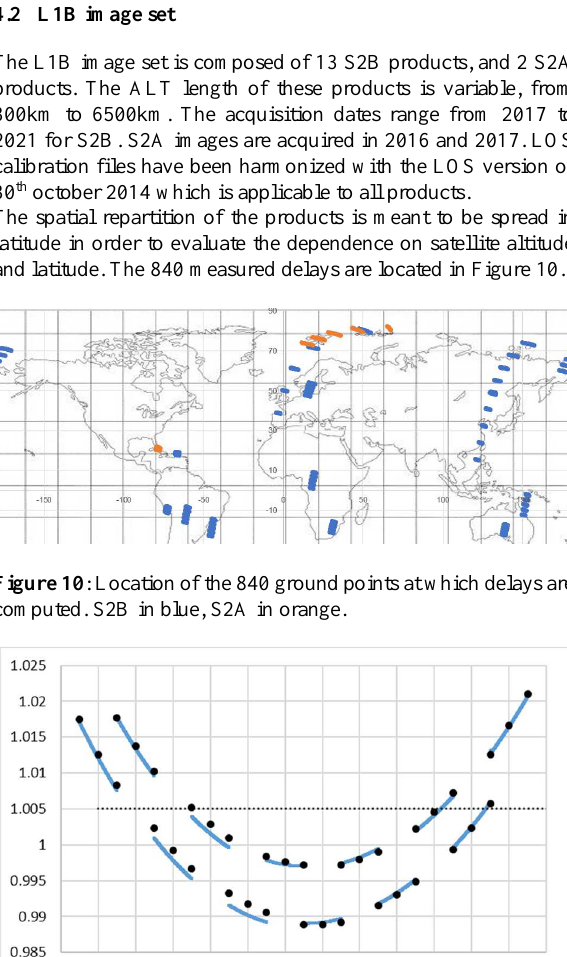
Figure 9 : Principle of delay estimation through image co- location illustrated on B2 and B4 bands.